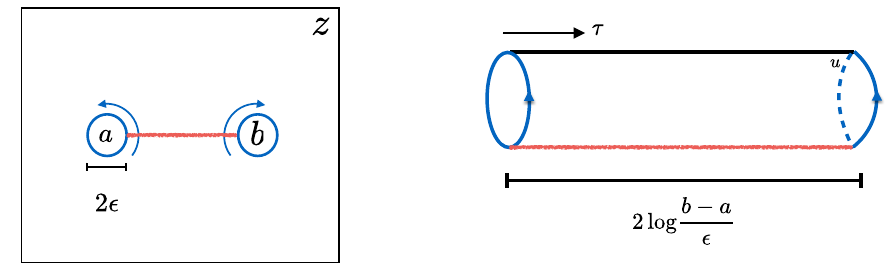
Figure 7 . The regulated z plane can be conformally mapped to the cylinder geometry on which the modular hamiltonian is equal to the physical hamiltonian of the CFT. In the \open string" channel, this is a thermal state at temperature 2 (cid:25) . In the \closed string" channel, this an amplitude between closed string boundary states living on the Hilbert space of a